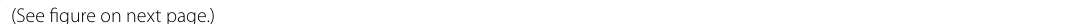
a 30 mm, b 60 mm, c 90 mm, d 120 mm (Note =